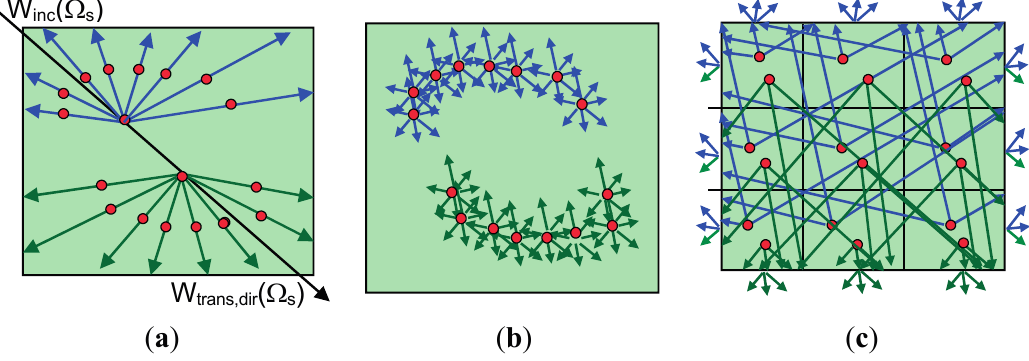
Figure 7. Turbid cell volume scattering: ( a ) two 1st order interception points per incident ray with associated first order scattered rays, and their second order interception points (red), ( b ) analytically computed within-cell second order scattering, and ( c ) first order interception points, which are grouped per incident angular sector and per cell sub-face crossed by the incident rays. Rays exiting the cell are grouped per exiting cell sub-face and per discrete direction.